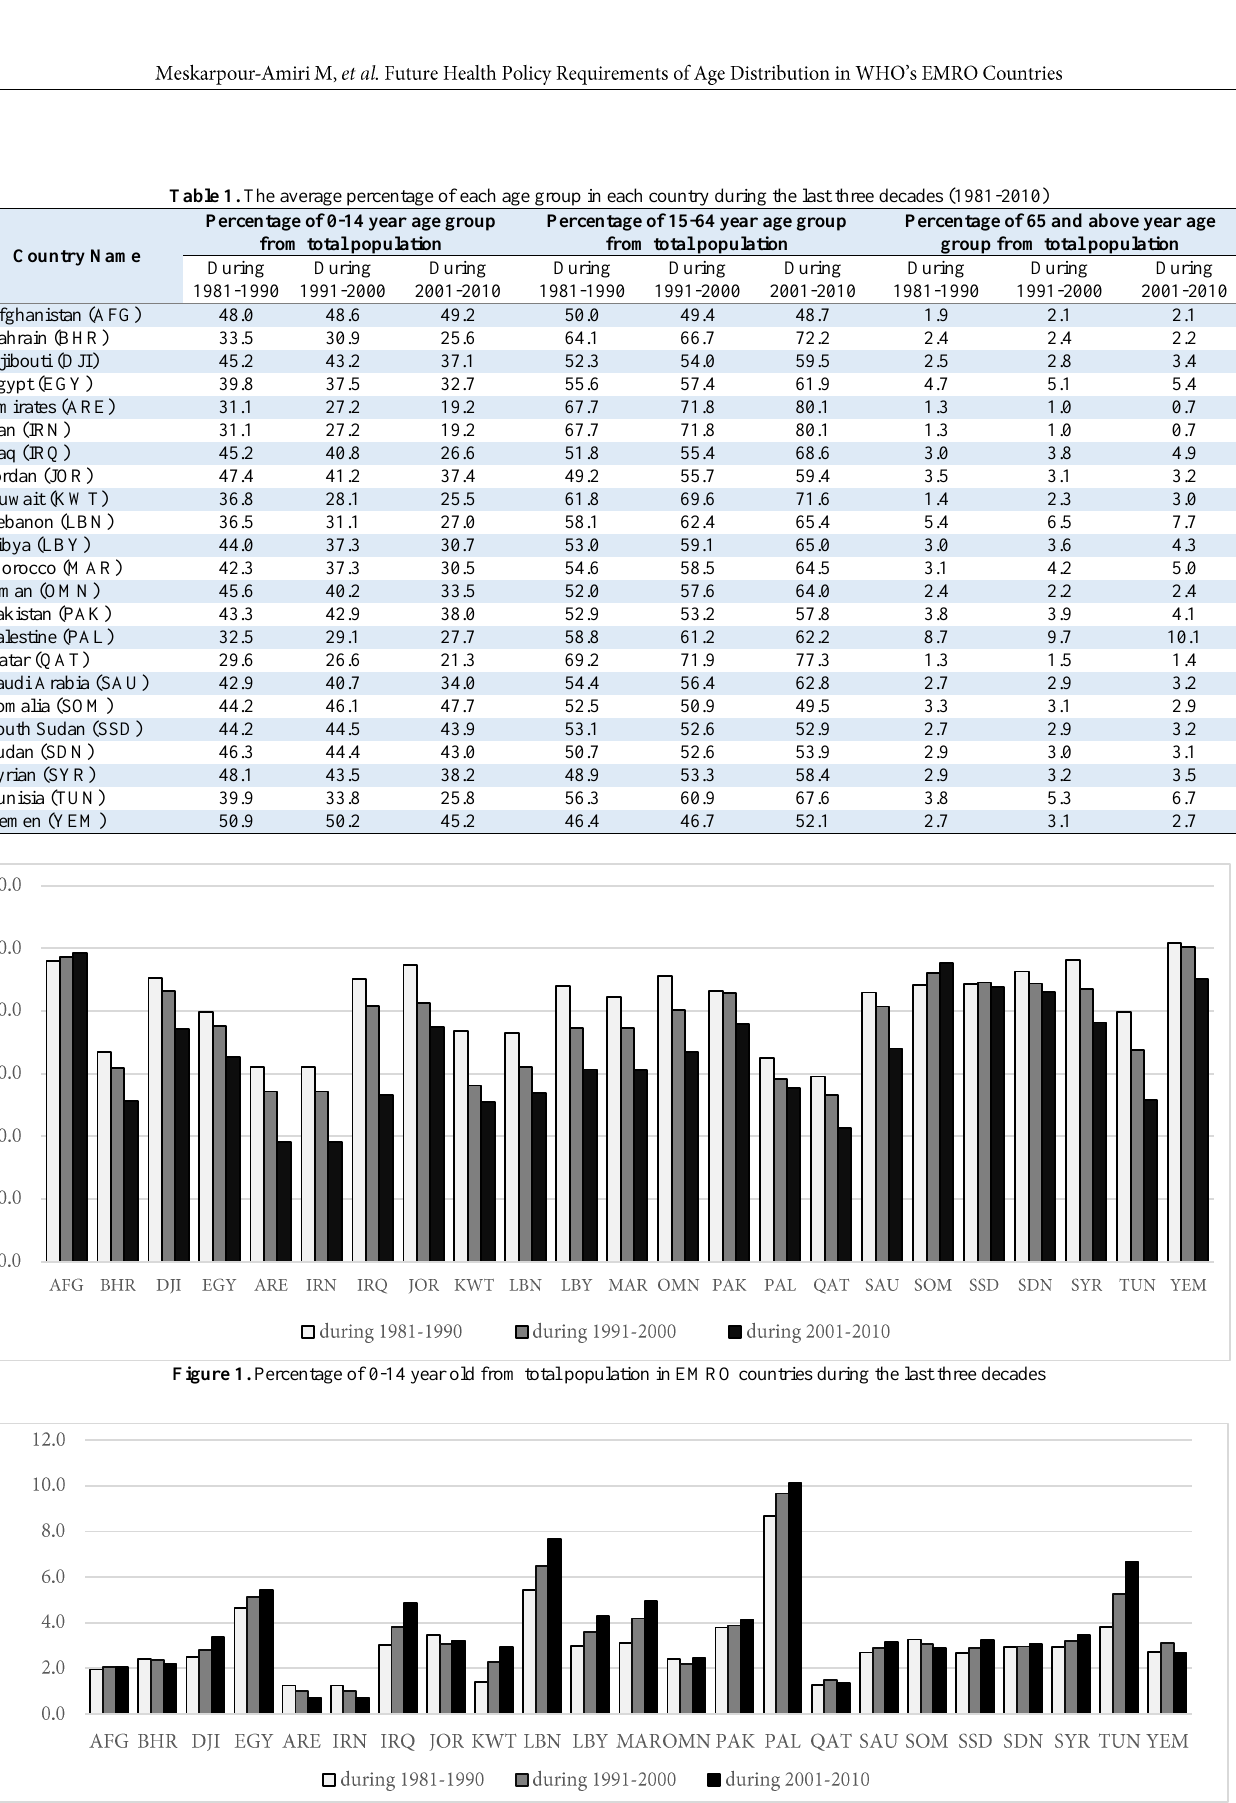
Figure 2. Percentage of 65 and above year olds from total population in EMRO countries during last three